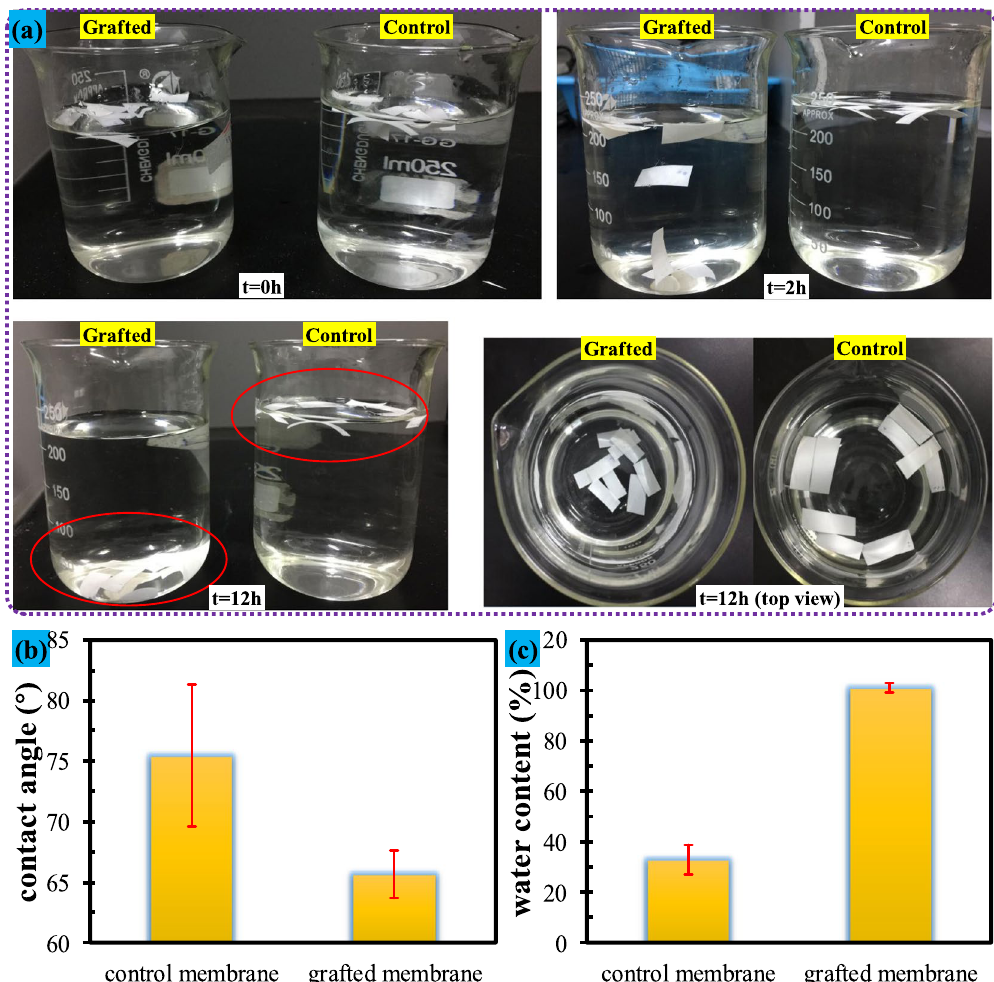
Figure 6. Settling ability, water contact angle and water content ratio of the control and grafted membranes: ( a ) settling ability; ( b ) water contact angle; ( c ) water content